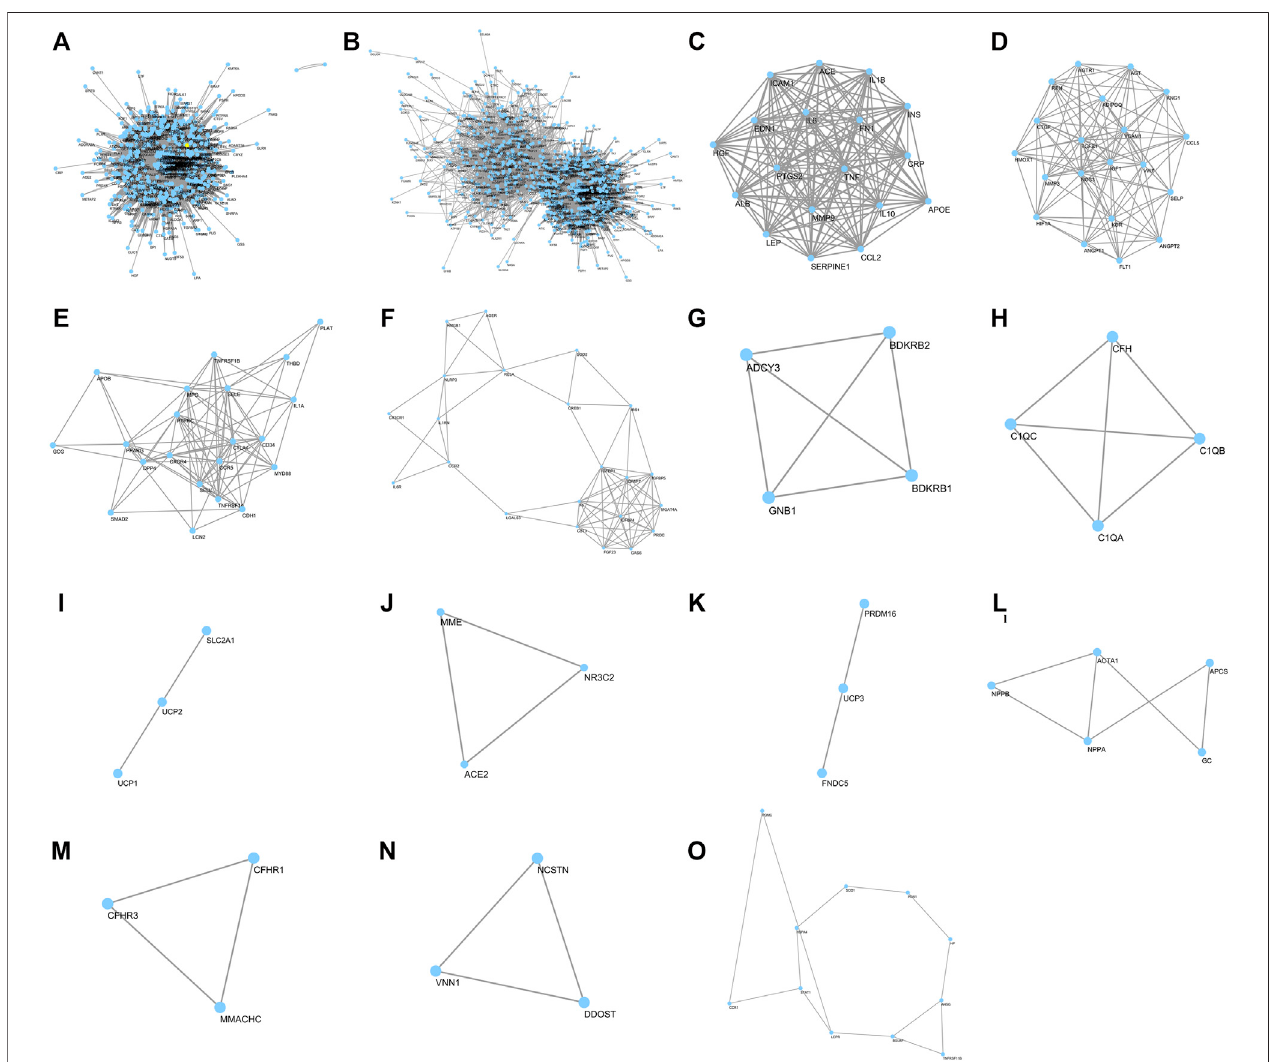
TABLE 2 | List of common proteins between diabetic nephropathy and R-6 variations. Between DN and